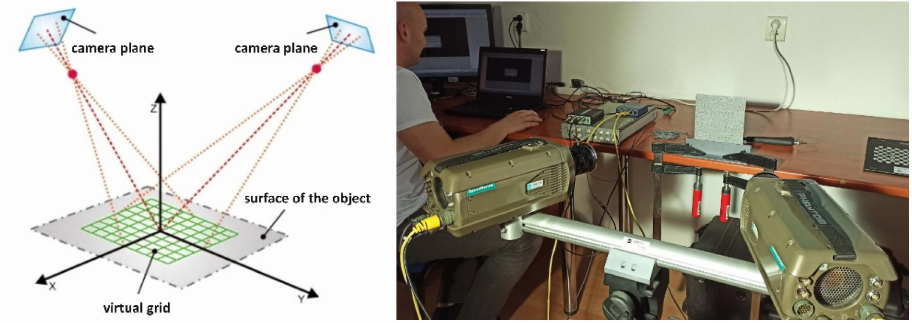
Figure 3. Q-450 measuring system with stereoscopic Phantom v310 camera